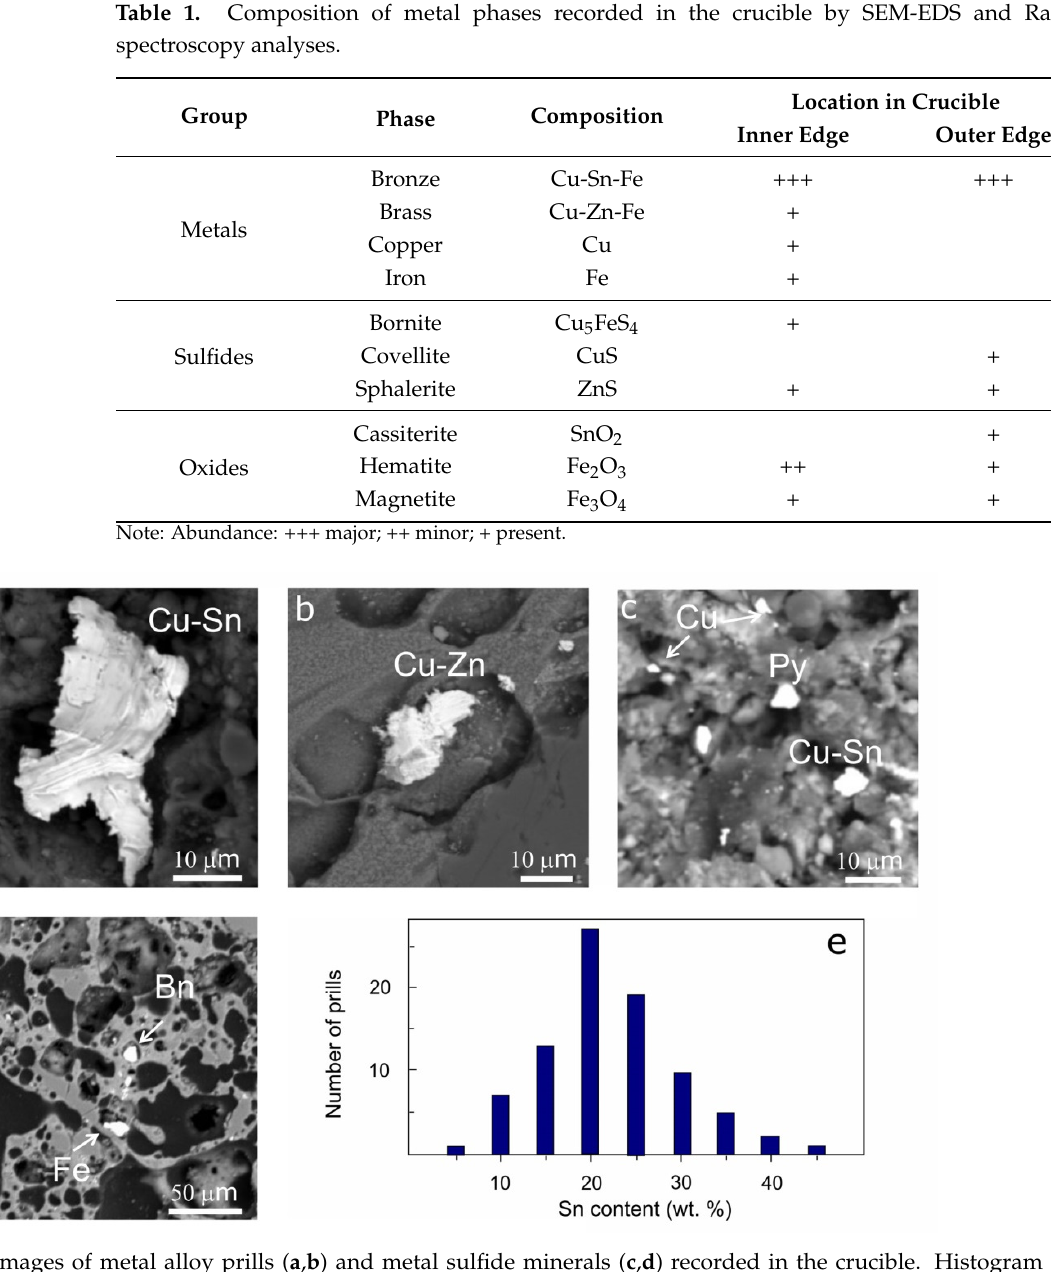
Figure 8. BSE images of metal alloy prills ( a , b ) and metal sulfide minerals ( c , d ) recorded in the crucible. Histogram ( e ) shows the prill frequency over bronze alloy compositions. Abbreviations: Cu-Sn—binary tin bronze; Cu-Zn—brass; Cu—copper; Fe—iron; Bn—bornite; Py—pyrite.